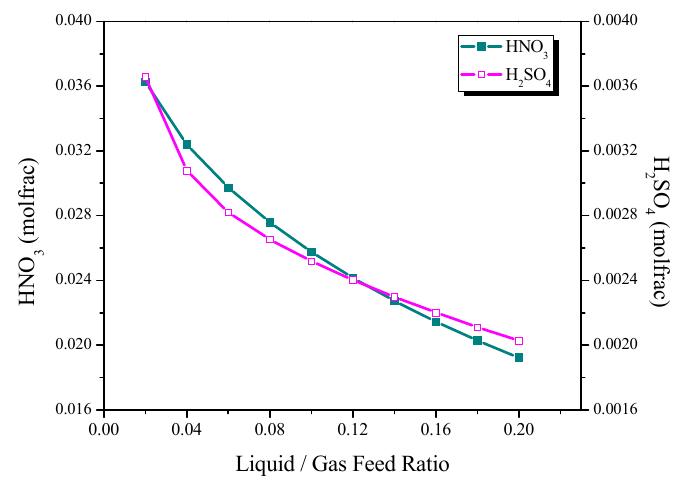
Figure 9. Effect of liquid/gas feed ratio on liquid product composition.